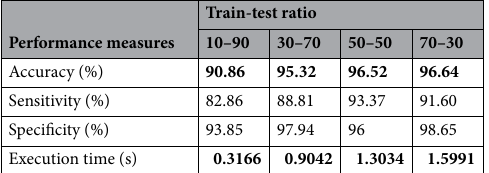
Table 5. Performance measures obtained on KELM classifier. Significant values are in